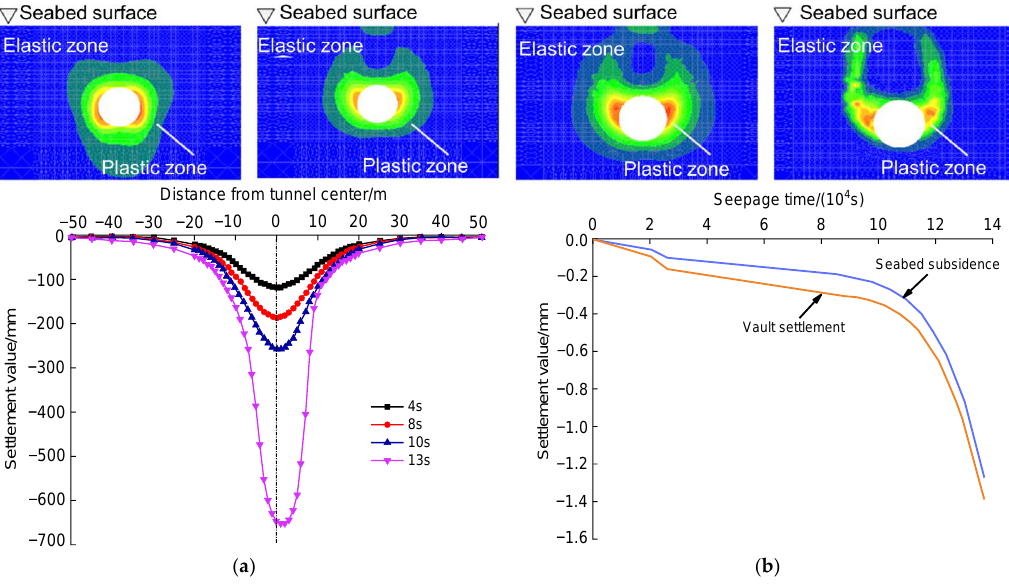
Figure 15. Evolution process and characteristics of the formation of collapsed ground [67]. ( a ) Changes in seabed settlement; ( b ) corresponding relationship between seabed and dome settlement.